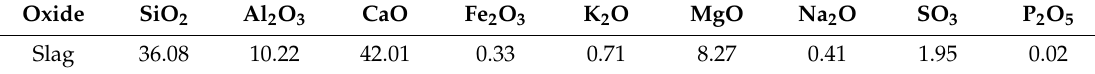
Table 1. Chemical composition of blast furnace slag (%).